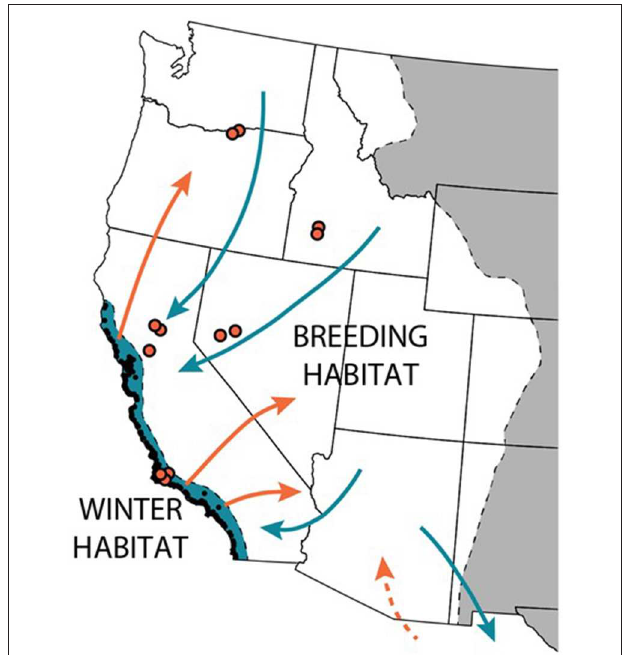
FIGURE 1 | Western monarchs breed west of the Rocky mountains and primarily overwinter at over 200 sites (black points) along the Pacific coast in California. During the spring, monarchs leave the overwintering habitat (colored blue) to disperse (orange arrows) across the West. The butterflies breed continuously across the West during the summer (colored white); in the fall, they return (blue arrows) to the overwintering grounds. [Tag recoveries in Mexico show that at least some western monarchs migrate to central Mexico, mixing with the eastern monarch overwintering population; whether or not monarchs from Mexico return to the West in the spring has not been documented, but is suspected (dashed orange arrow)]. The authors have monitored monarch breeding phenology and milkweed at 12 sites throughout the West (orange points) as part of a multi-year study.